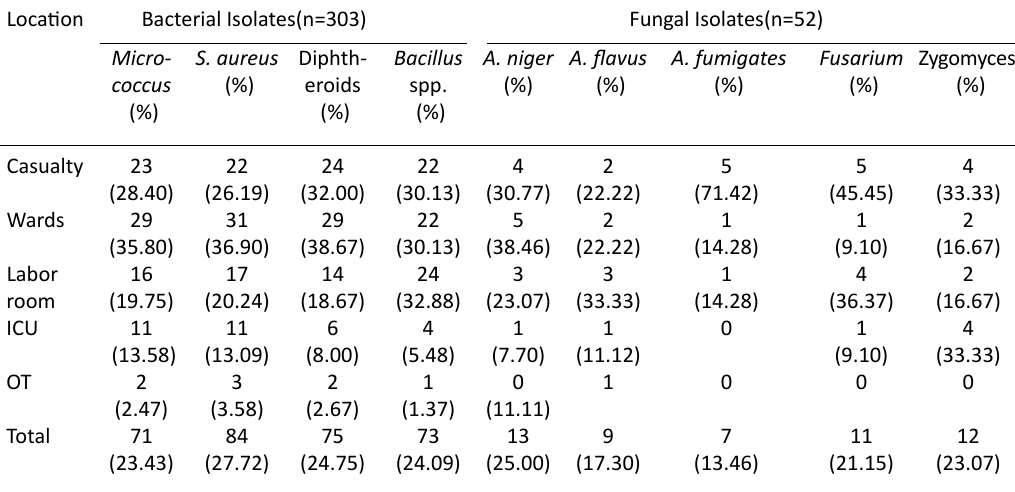
Table 1. Percentage bacterial and fungal positivity on different locations in the hospital Location